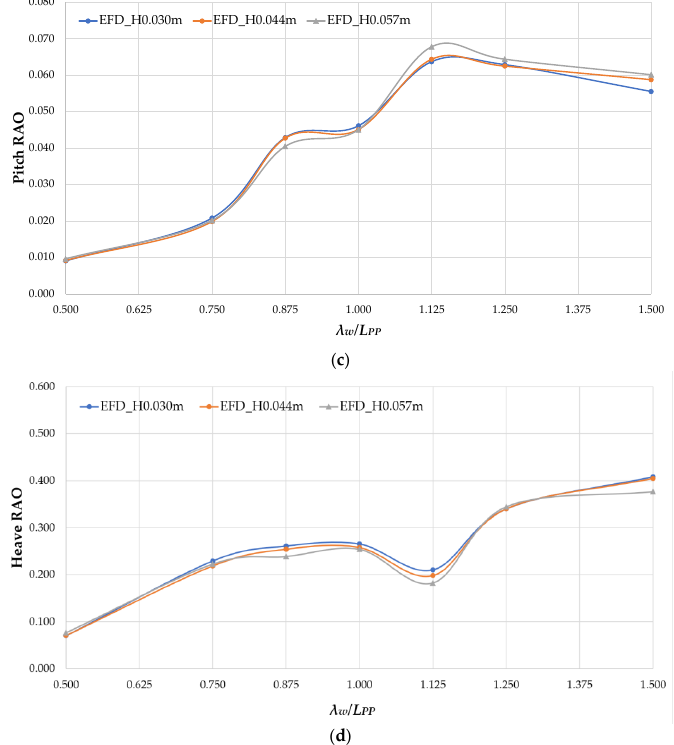
Figure 6. EFD results for the lowest speed corresponding to 𝐹 𝑅 = 0.131: ( a ) added resistance in waves; ( b ) added resistance coefficient; ( c ) Pitch RAO; ( d ) Heave RAO. Usually, the added resistance curve has only one peak where the wavelength is ap- proximately equal to the ship length. However, for the lowest ship speed, the curve shows two local maxima: one at λ w / L PP = 0.875 and the other at 1.125. This trend is consistent for all the wave heights, as shown in Figure 6a. It is also possible to notice that the double resonance phenomena are more significant with the increase in wave steepness. On the contrary, only one peak value can be seen for the higher ship speeds, as shown in Figure 7. The pitch motions presented in Figure 6c show a good correlation between the pitch curve and non-dimensionalised added resistance in waves. Two local maxima corre- sponding to λ w / L PP = 0.875 and λ w / L PP = 1.125 also appear on the pitch curve. The heave RAO curves for the lowest speed drop significantly at λ w / L PP = 1.125. However, no heave drop can be noticed for the wavelength of λ w / L PP = 0.875. This may suggest that the unex- pected increase in added resistance coefficient could be related to increased pitch motions. In addition, it is also possible to see that wave amplitude has a small influence on the heave and pitch RAOs. Another observation that can be made is related to wave steepness. Increasing the steepness does not affect the double resonance phenomena, and the only thing that changes is the migration of the absolute maximum from λ w / L PP = 0.875 at lower steepness to the λ w / L PP = 1.125 at highest steepness.